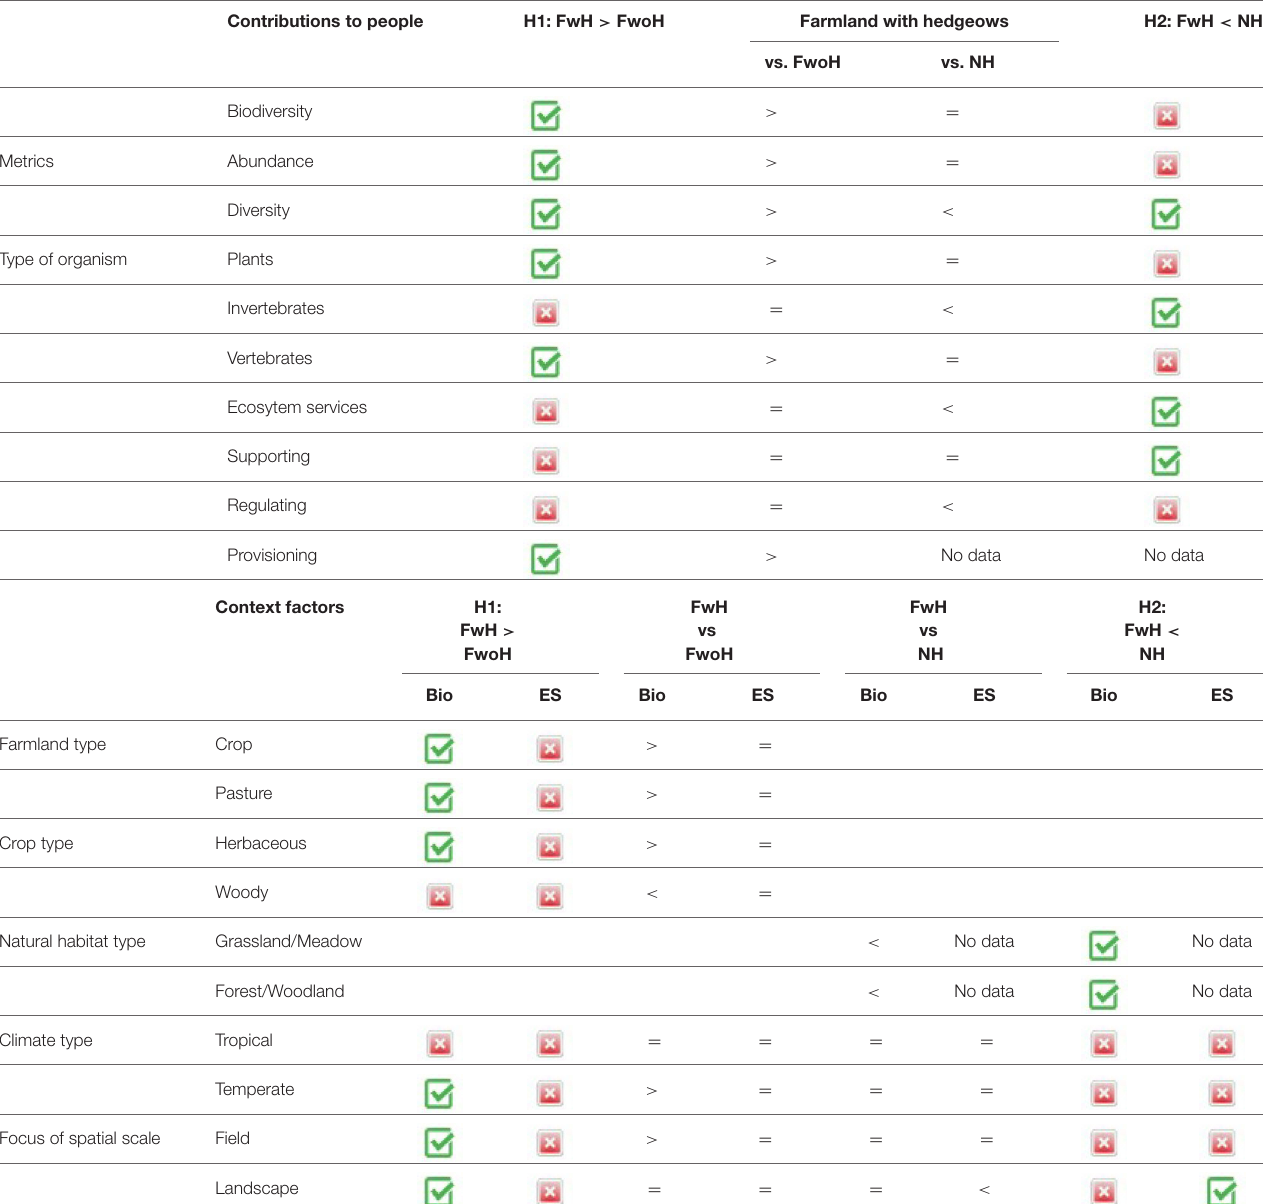
TABLE 3 | Summary of comparisons of biodiversity (Bio) and ecosystem service (ES) levels between farmland with hedgerows (FwH) and farmland without hedgerows (FwoH), and between farmland with hedgerows (FwH) and natural habitat